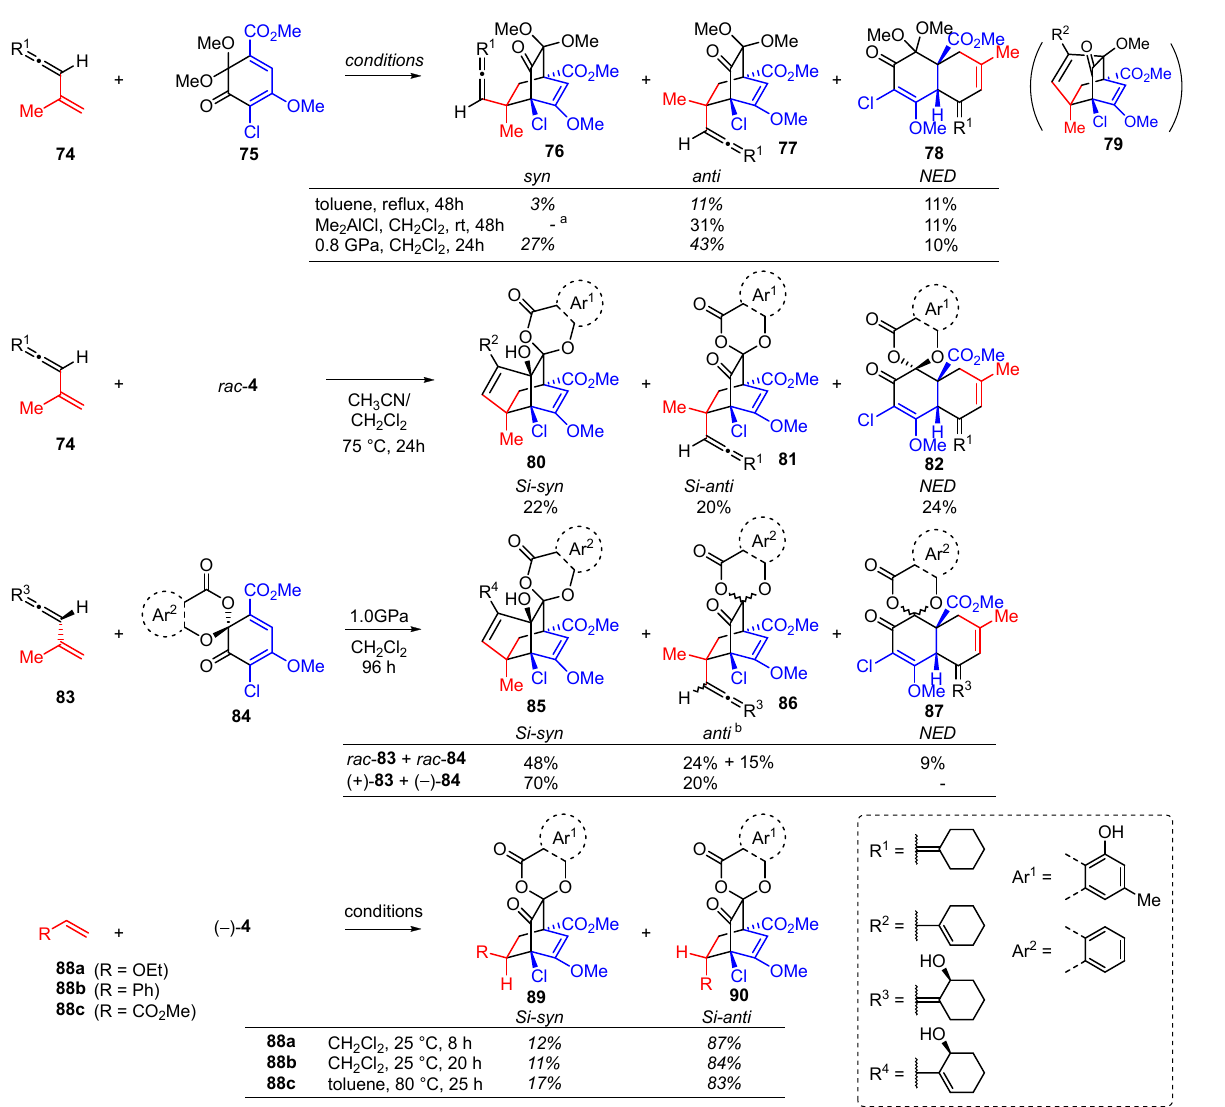
Scheme 8. Model studies on the intermolecular Diels–Alder reaction toward the biomimetic synthesis of chloropupukeananin. All yields in italics are calculated by 1 H NMR. a carbonyl-ene isomer 79 derived from 76 was obtained (11% yield). b the whole structure could not be identified.